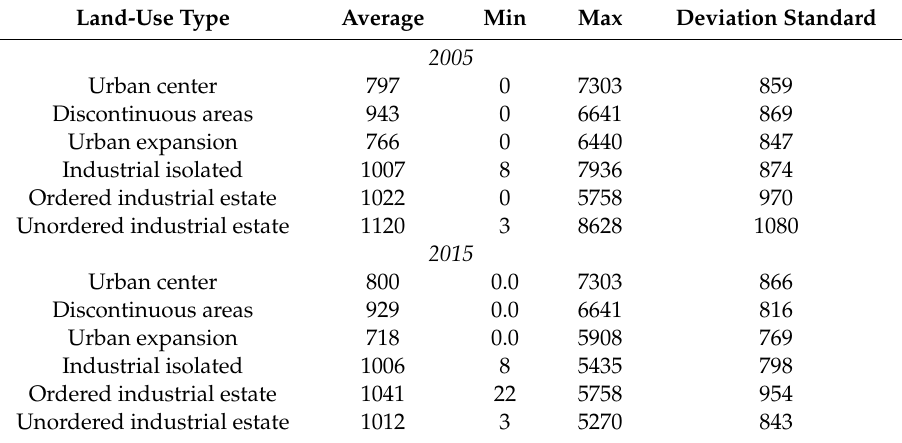
Table 3. Distance (m) among residential and industrial sites from natural areas.